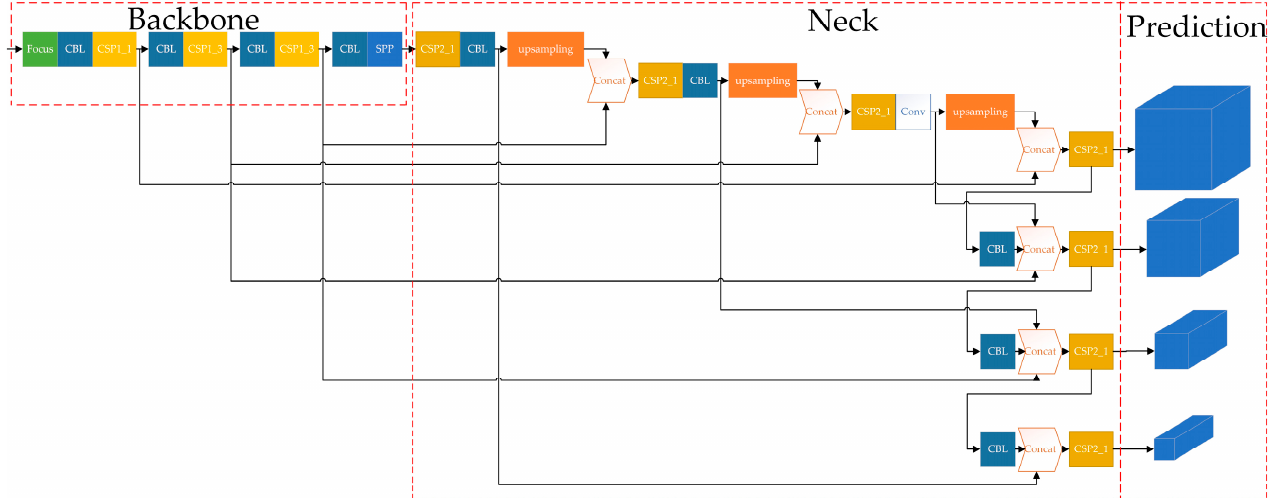
Figure 10. MS-YOLOv5s network architecture.